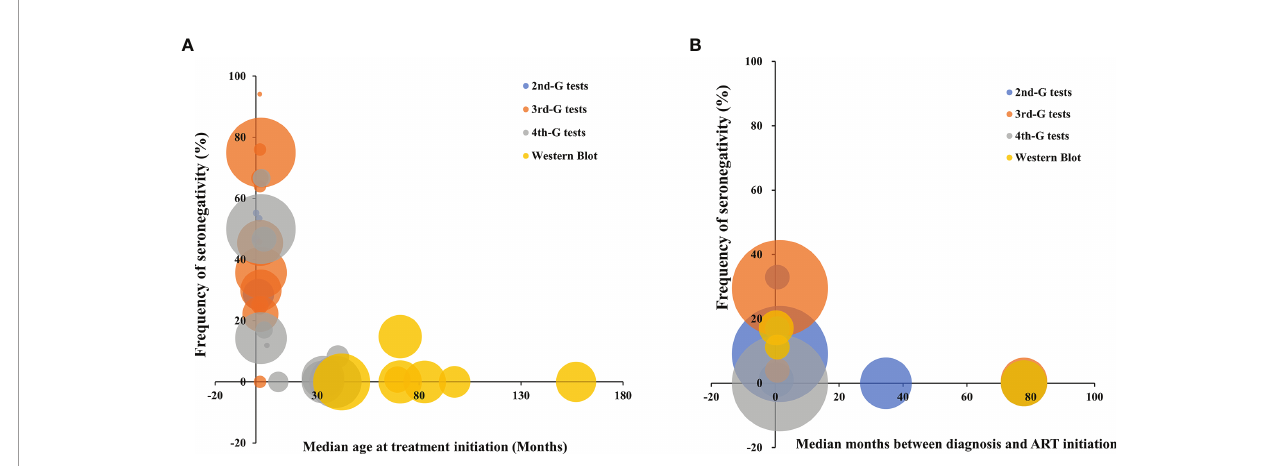
FIGURE 4 | The distribution of frequency of HIV-1 seronegativity in cART-treated vertically HIV-infected children (A) and adult patients (B) according to the time of cART initiation and the principles of HIV-1 serological assays. Bubble size is proportional to the duration of cART. 2nd-G test, HIV-1 serological test based on second-generation principle; 3rd-G test, HIV-1 serological test based on third-generation principle; 4th-G test, HIV-1 serological test based on fourth-generation principle; cART, combination antiretroviral